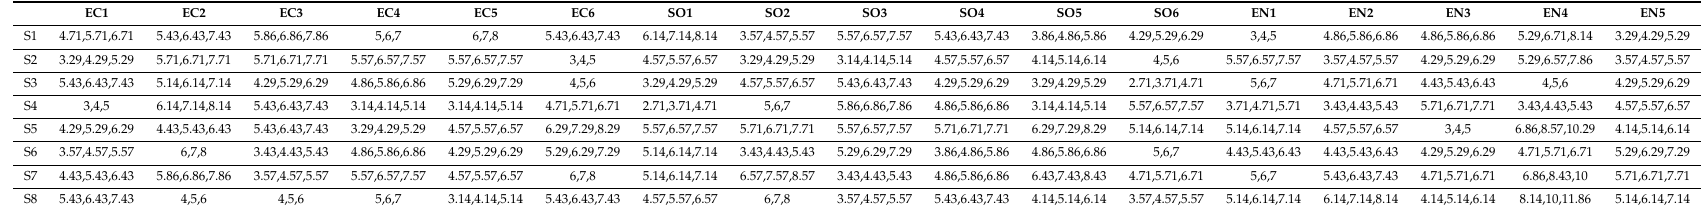
Table A10. Fuzzy decision matrix.